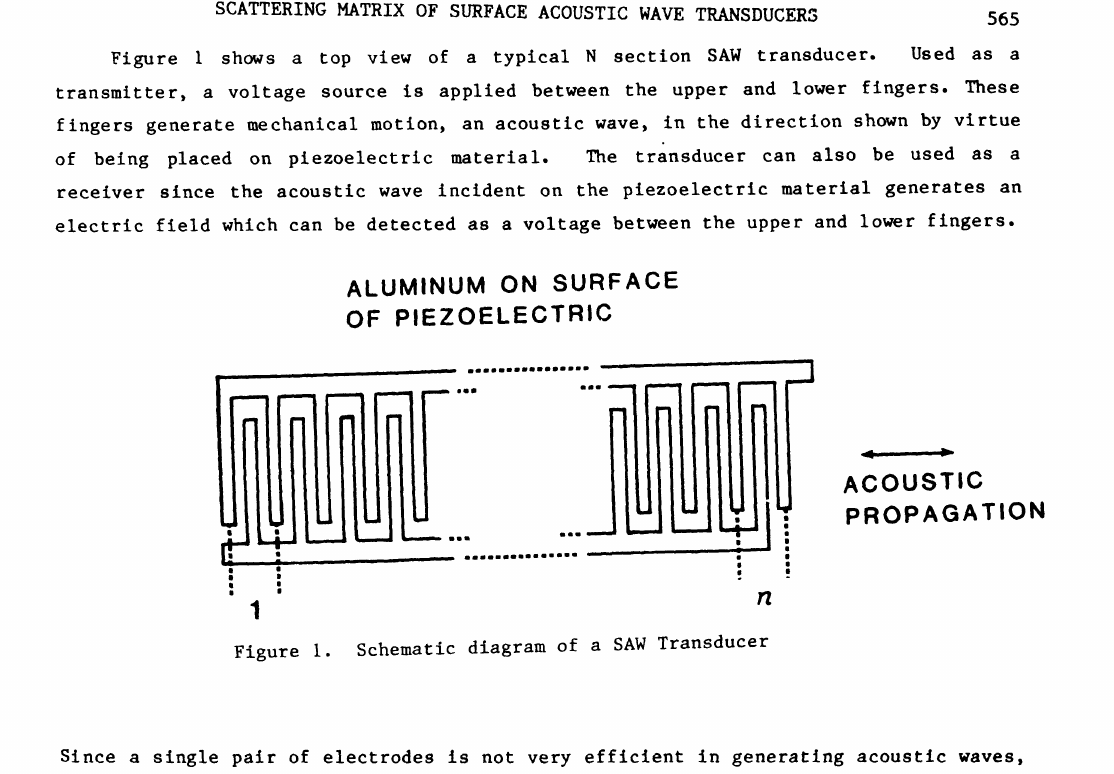
Figure I. Schematic diagram of a SAW